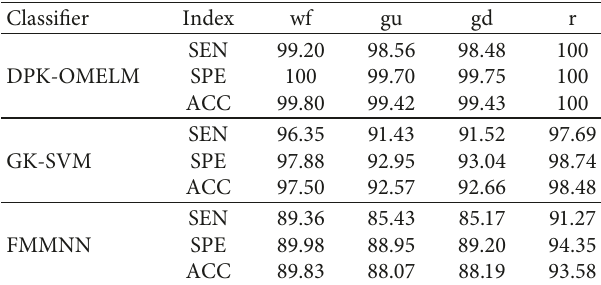
Table 8: SEN, SPE, and ACC of each gait activity under DPK- OMELM, GK-SVM, and FMMNN (%).